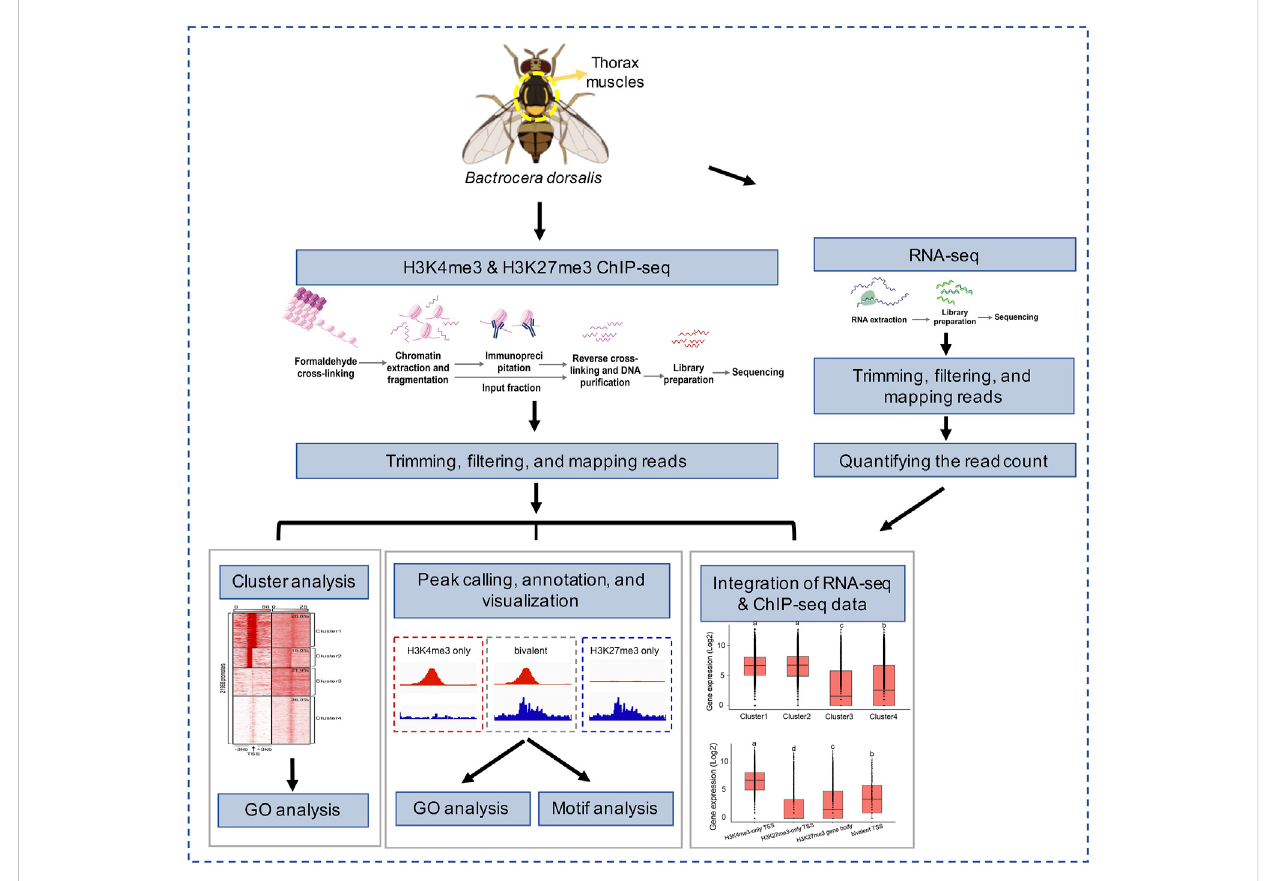
FIGURE 1 Overview of experimental design and data